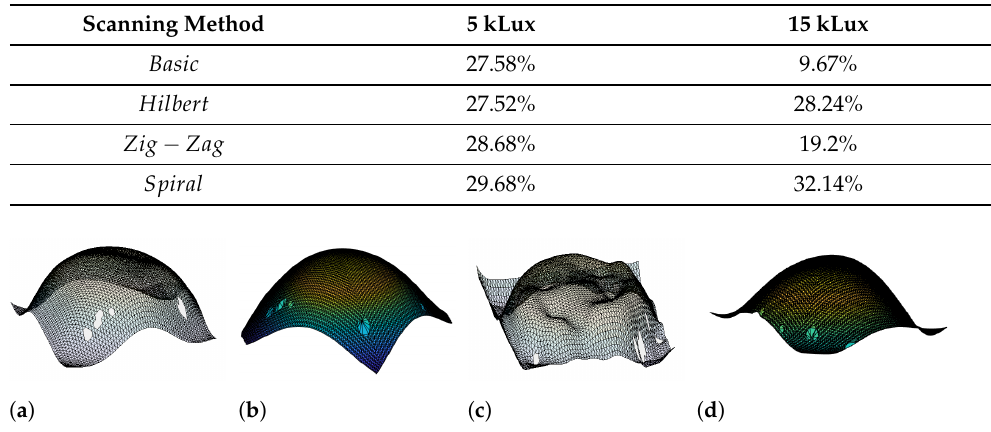
Figure 12. Three-dimensional (3D) mesh sphere without/with fog conditions: ( a ) without fog mesh using SFS with Skewness = 0.6, ( b ) mesh improving power crust and iToF with Skewness = 0.09, ( c ) with fog mesh using SFS with Skewness = 0.8, and ( d ) mesh improving power crust and iToF with Skewness =